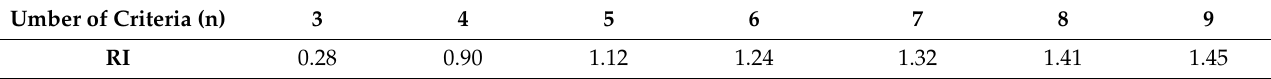
Table 3. Random consistency index test (RI) table.